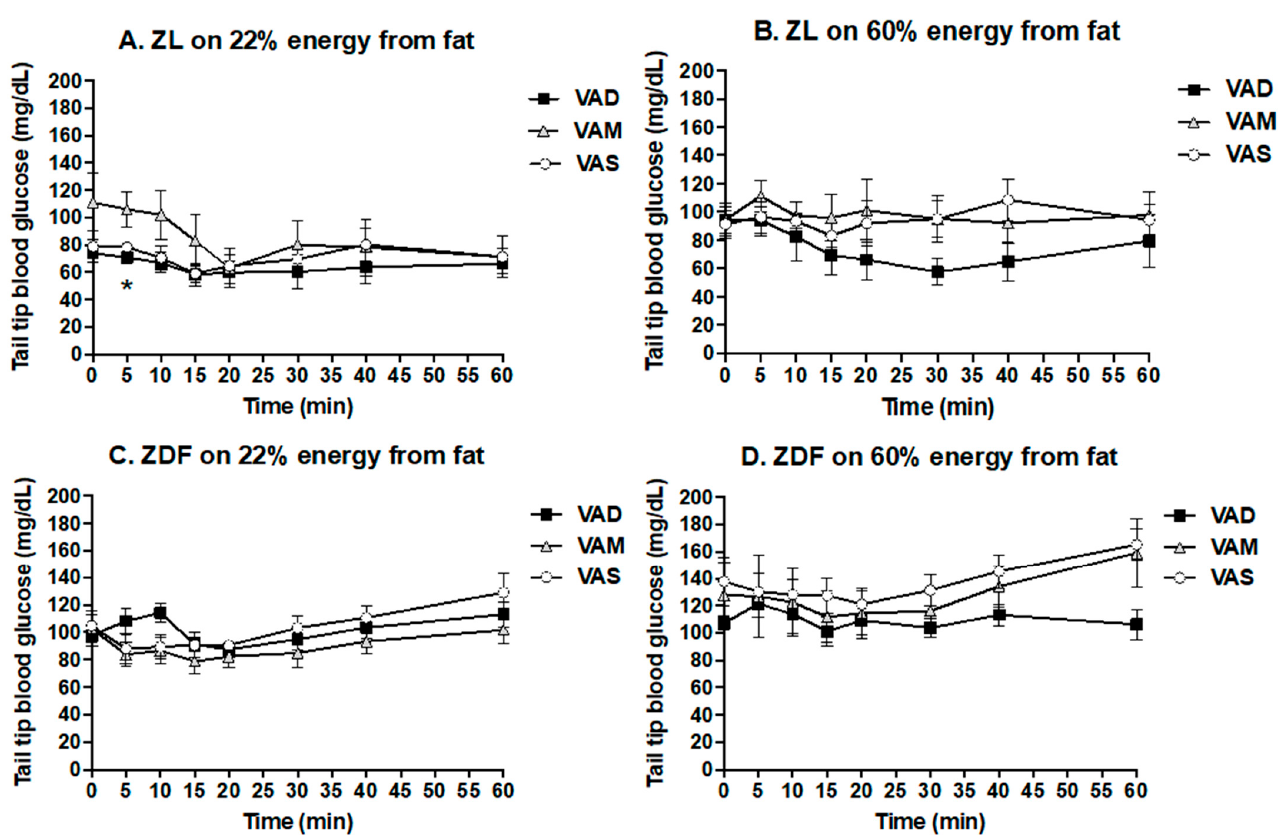
Figure 5. The peripheral blood glucose levels of ZL and ZDF rats fed a VAD, VAM or VAS diet with BF or HF content for 6.5 weeks in the insulin tolerance test. Data are expressed as mean ± SEM, n = 5–6 per group; * p < 0.05 for comparing the VAS ‐ BF group with the VAD ‐ BF and VAM ‐ BF group.